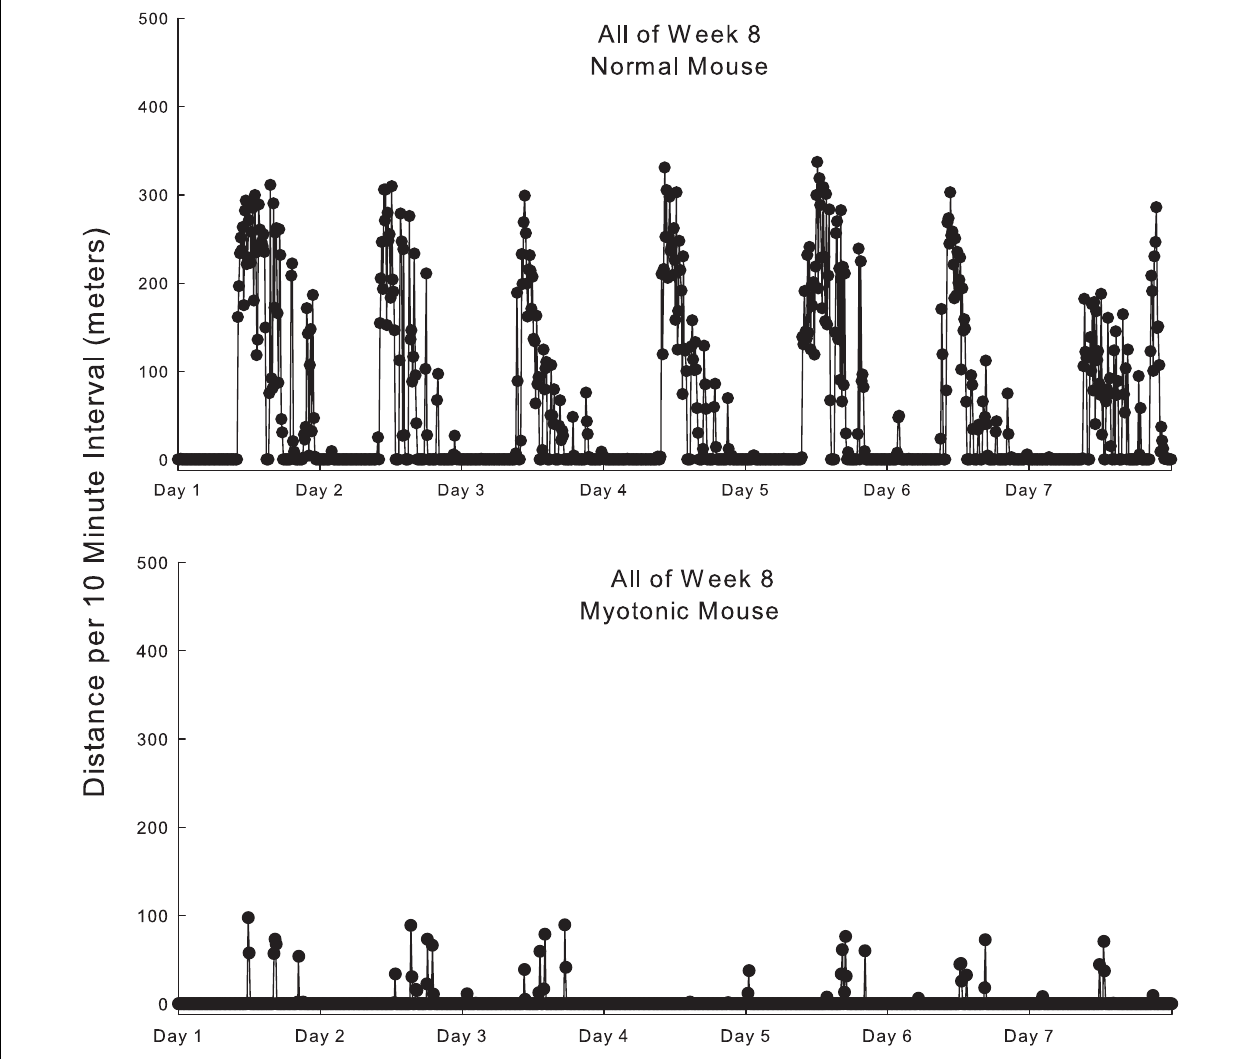
FIGURE 1 | Example of running behavior of a normal and myotonic mouse during all of week 8. The distance run is quantified for each 10min interval as a function of time during the day. Each day depicted is from 8 am one morning until 8 am the following